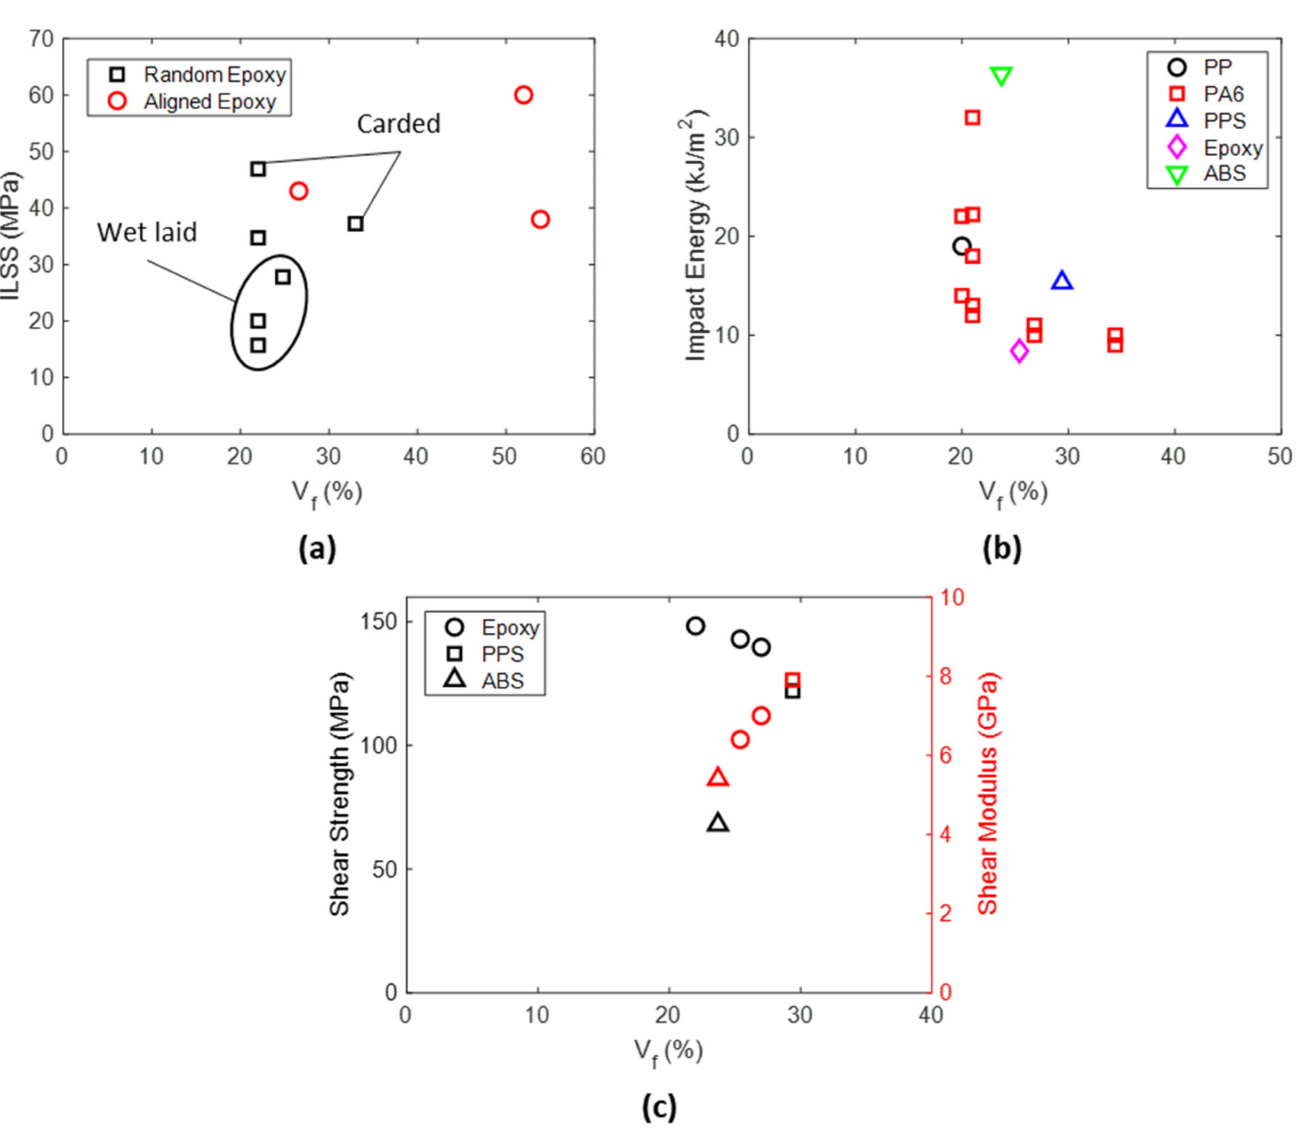
Figure 14. Various properties of recycled carbon fiber composites: ( a ) interlaminar shear strength [42,65,68,69,74,81], ( b ) IZOD impact energy absorption [63,64,77,80,88] and ( c ) in-plane shear strength